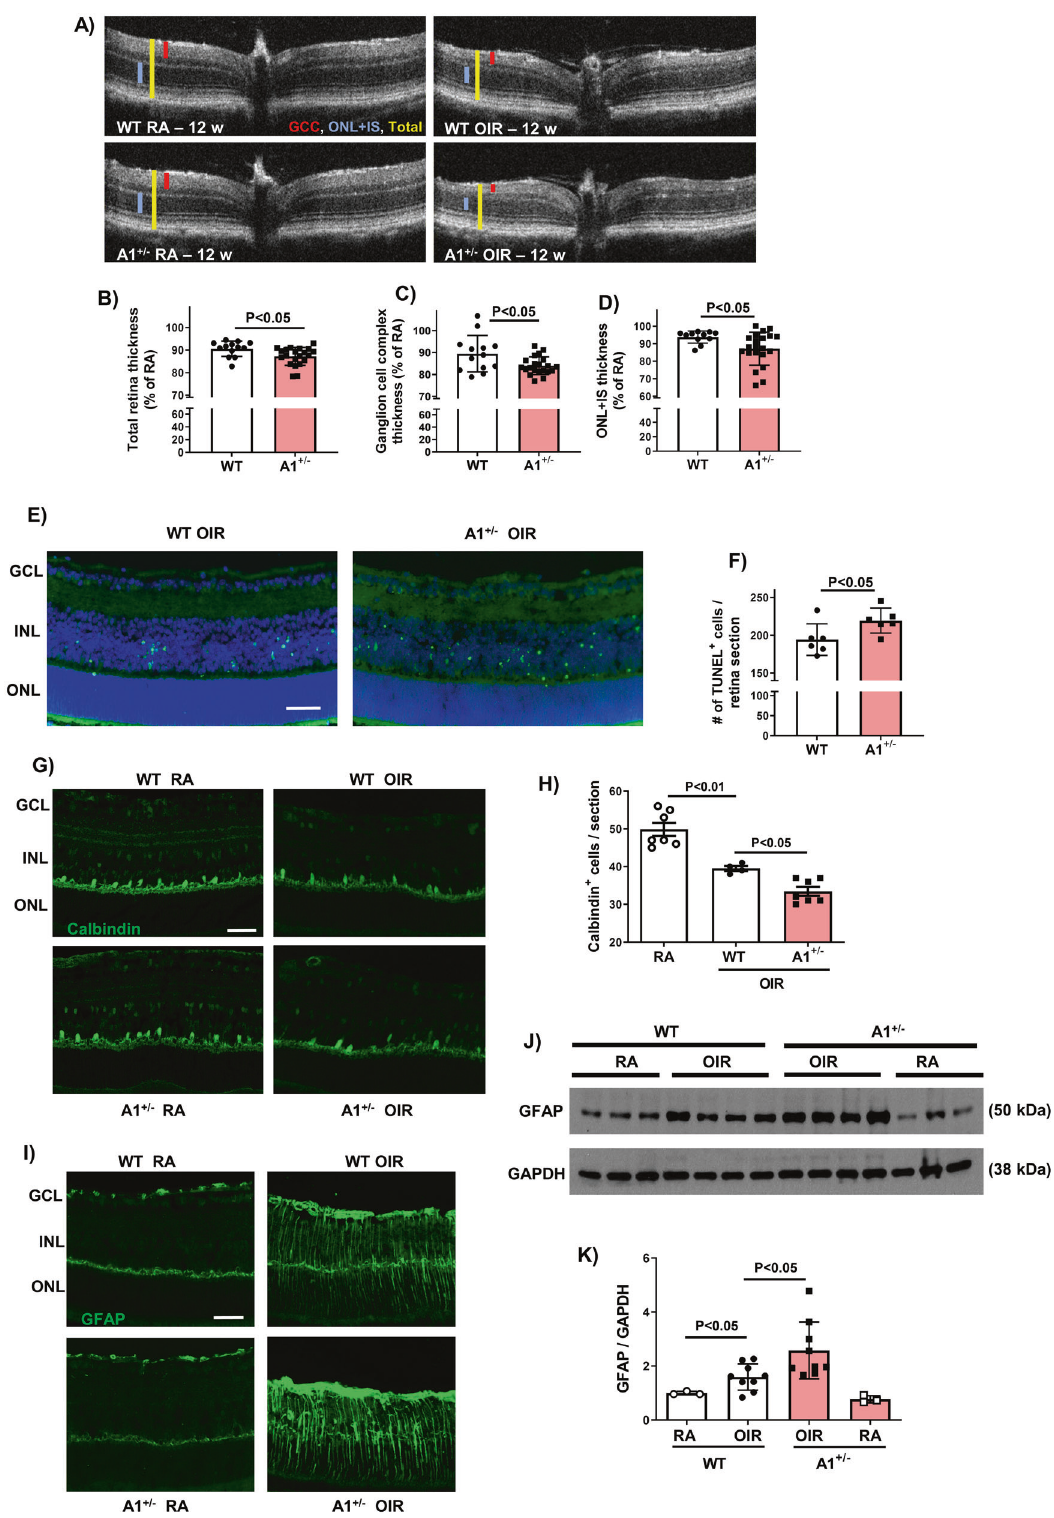
Fig. 5 A1 deletion worsens retinal thinning, apoptosis, horizontal cells loss, and glial activation after OIR. A – D SD-OCT analysis of 12- week-old mice retinas showed a signi fi cant reduction in thickness of the total retina, ganglion cell complex (GCC), and outer nuclear layer plus inner segments (ONL + IS) in the A1 KO OIR retinas as compared to WT OIR retinas. E , F TUNEL labeling and quanti fi cation at P9 showed a signi fi cant increase in TUNEL-positive cells in A1 KO OIR retina sections as compared to WT OIR retinas. Scale bar = 50 µm. G , H Calbindin labeling and quantitation of retina sections at P17 showed horizontal cell loss after OIR that was further aggravated in A1 KO OIR retinas. Scale bar = 50 µm. I – K GFAP immunolabeling of retina cross-sections at P17 showed increased expression of GFAP in Müller cells beyond their end- feet after OIR, which was further increased in A1 KO retinas. Western blotting on P17 retina homogenates and quanti fi cation con fi rmed the immunolabeling results. Scale bar = 50 µm. Cell Death and Disease (2022)